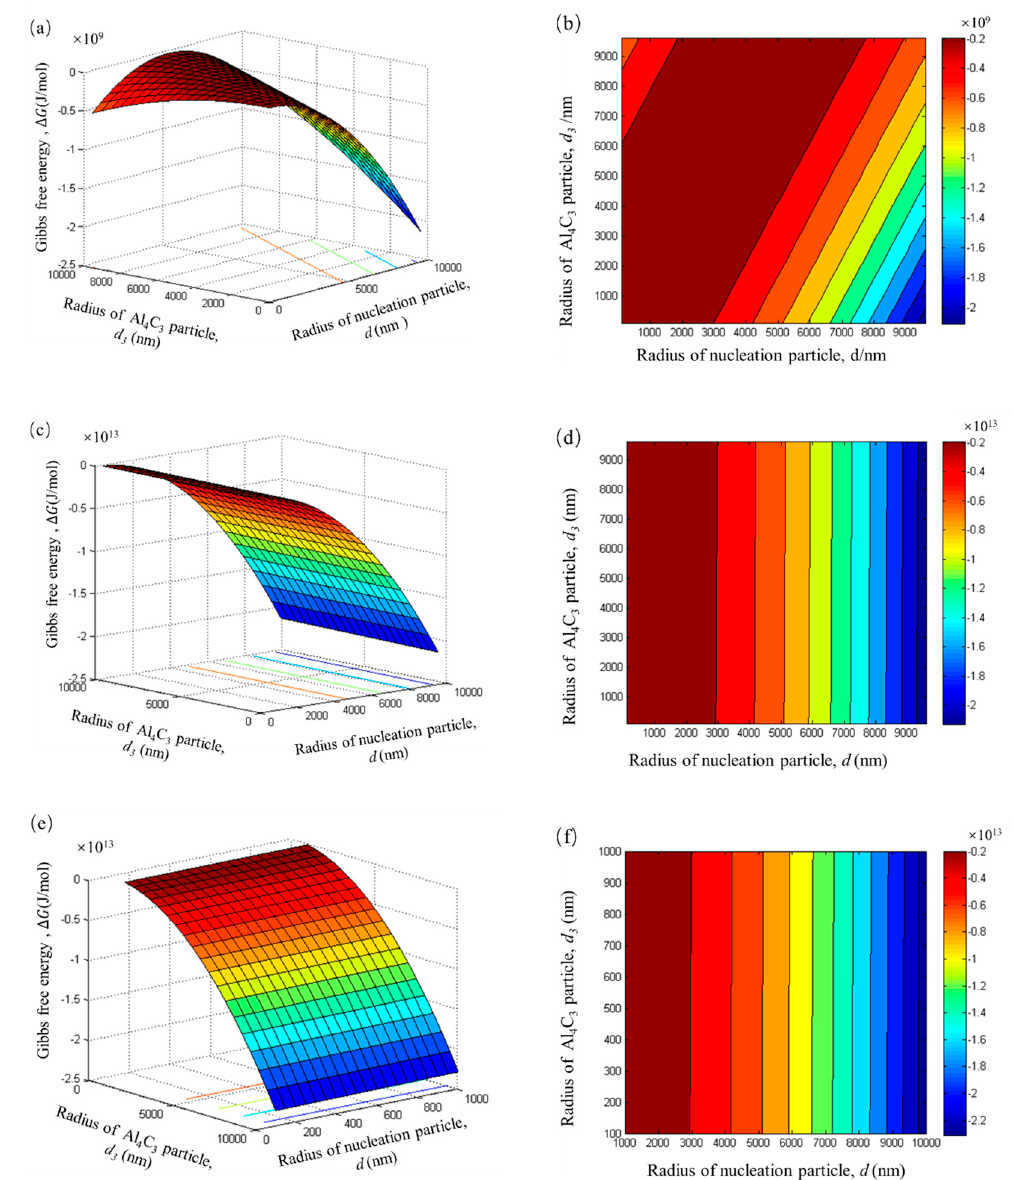
Figure11. TheGibbsfreeenergyofthecompetitivetrendwithdi ff erentlayers. ( a , b ): n = 1, ( c , d ): n = 100, Figure 11. The Gibbs free energy of the competitive trend with different layers. ( a ) and ( b ): n = 1, ( c ) ( e , f ): n = and ( d ): n = 100, ( e ) and ( f ): n = 1000.